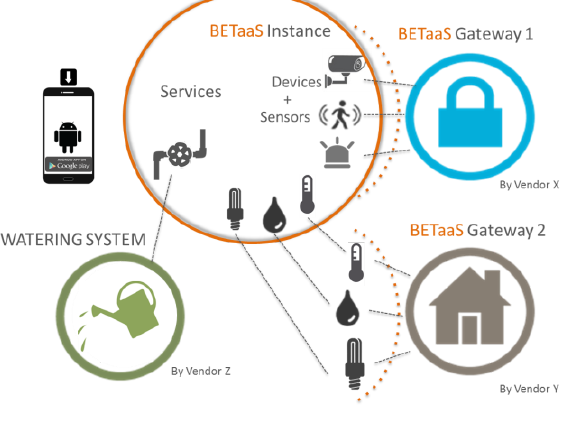
Figure 4. Smart home scenario deployment on BETaaS